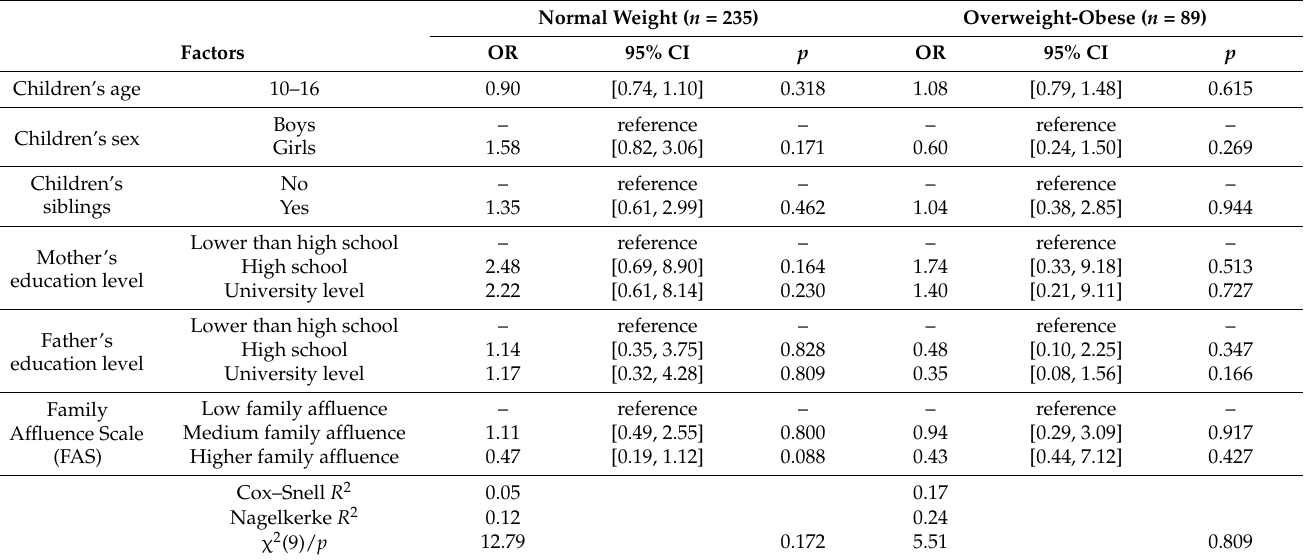
Table 3. Predictors of parents’ accuracy in identifying children’s weight category, by measured